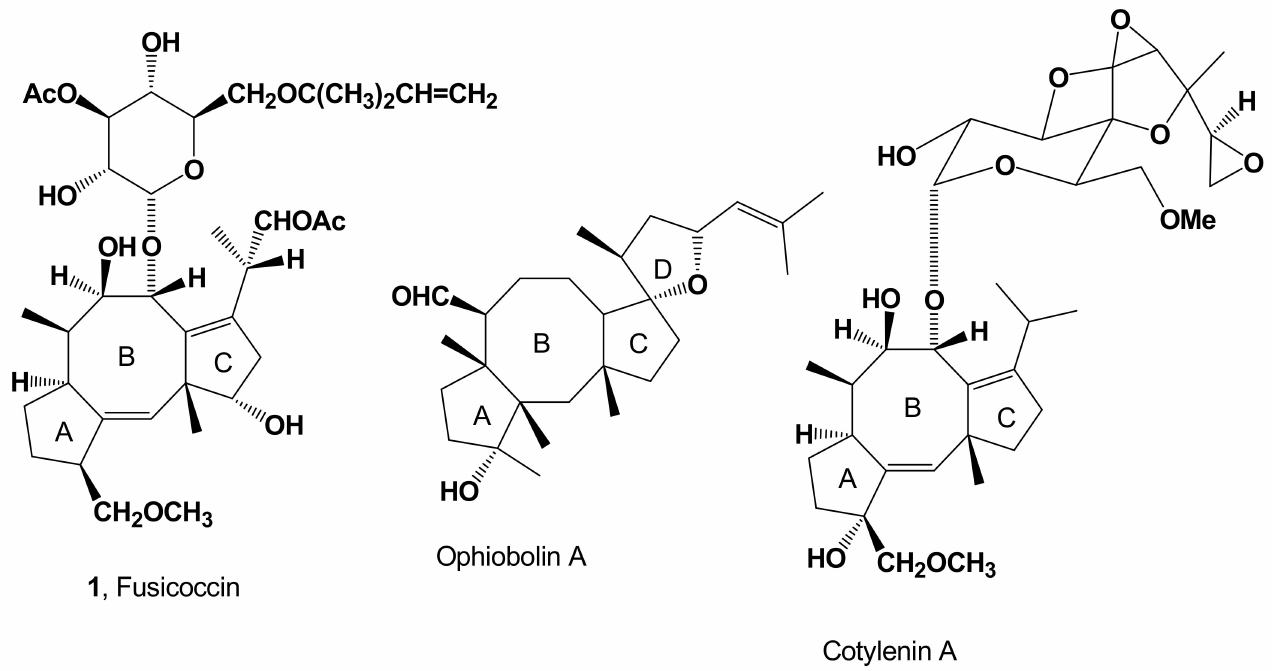
Figure 1. Structure of fusiccocin ( 1 ), ophiobolin A and cotylenin A, the main representative members of the three fusicoccanes-related families, sharing the same 5:8:5 carbotricyclic ring system. Table 1. List of biological activities of FC and of minor diterpenoid metabolites from P. amygdali and FC semisynthetic derivatives used to carry out structure-activity relationships and mode of action studies. MFRM: minor